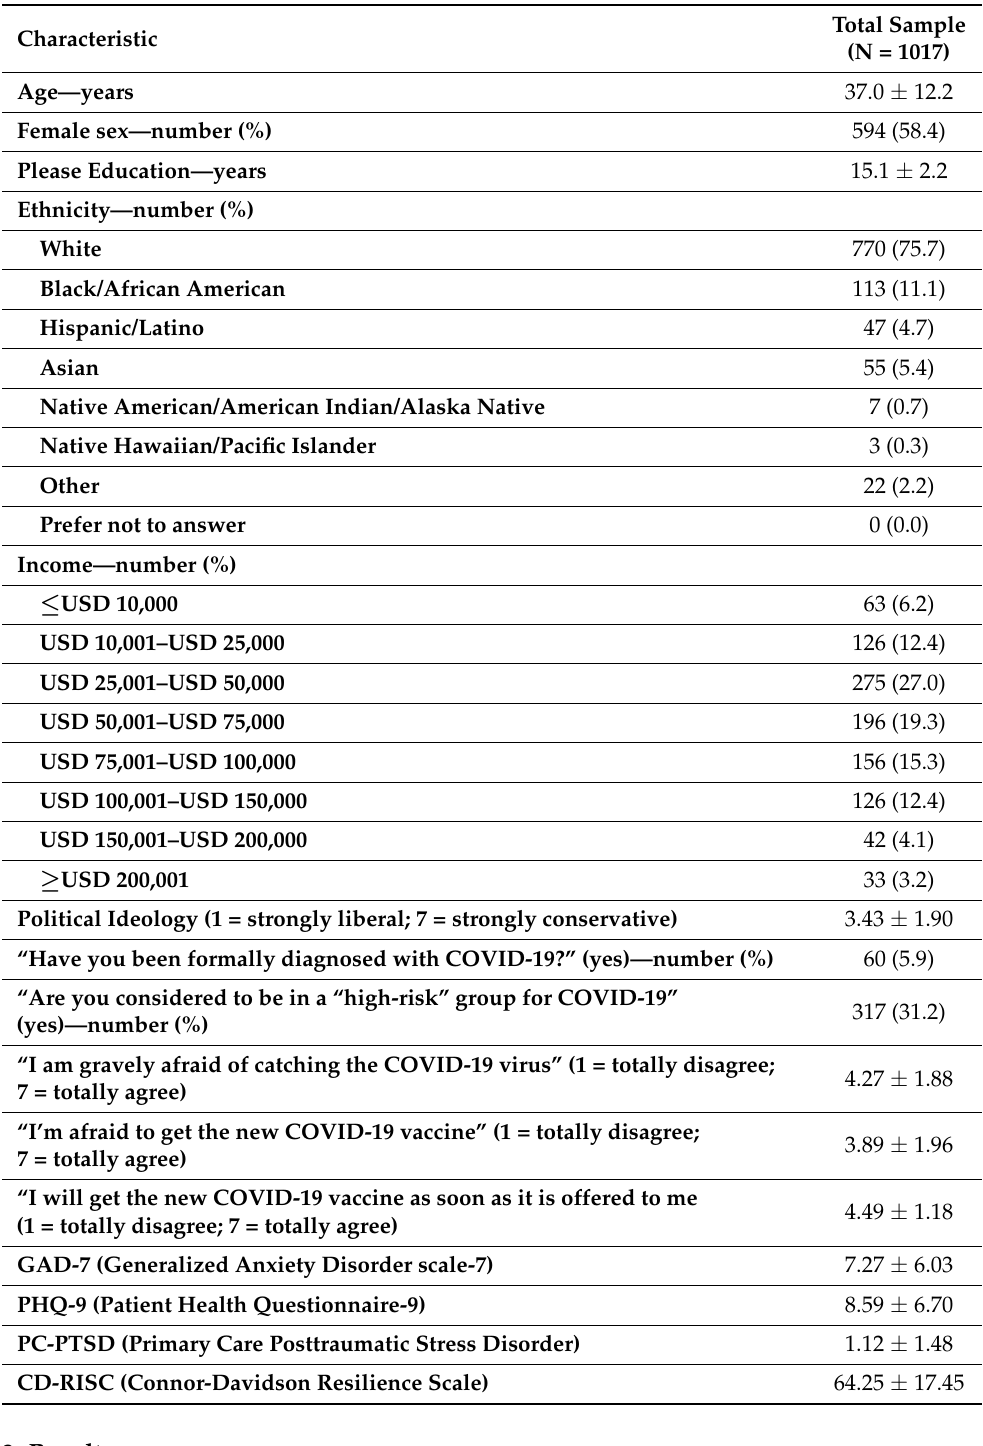
Table 1. Demographic Characteristics and Scores on Survey